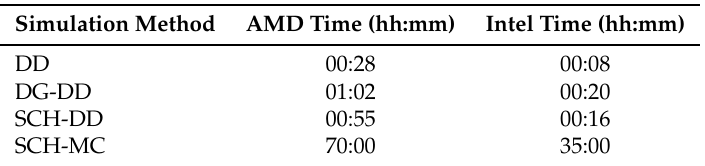
Table 2. Total time for the solution of one gate bias point as a function on the simulation method. Results have been obtained on a single core for two different CPUs: an AMD Opteron 6262HE